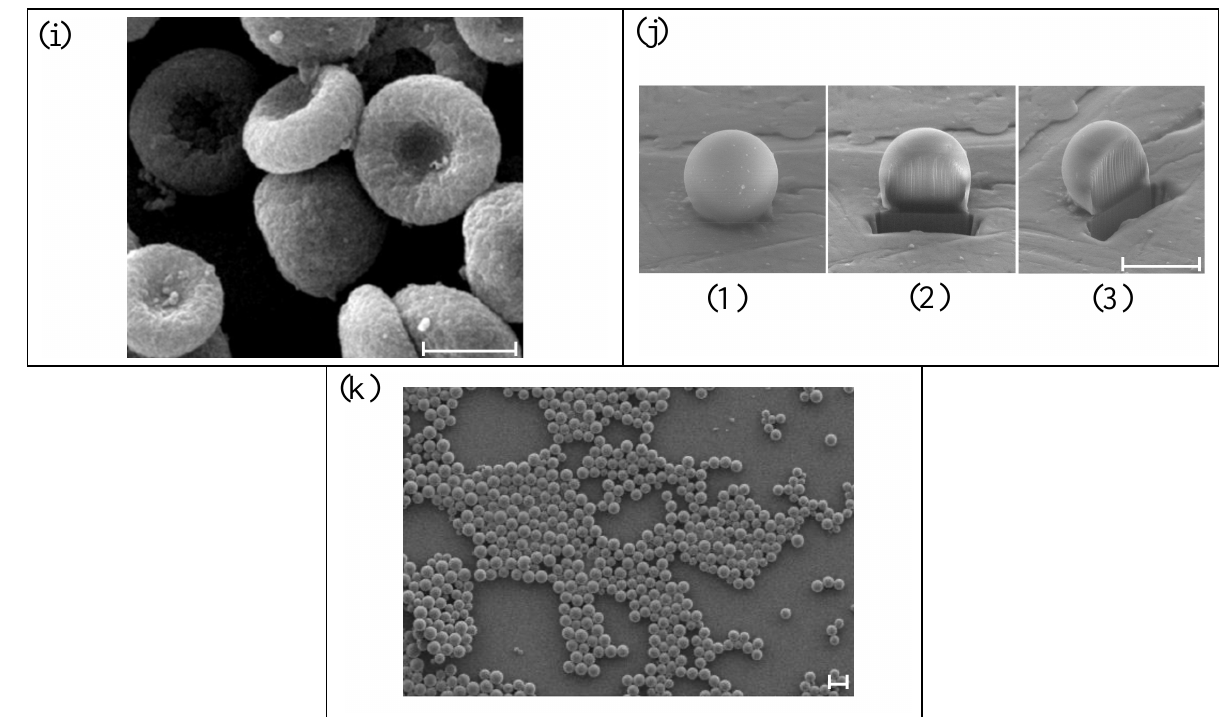
Figure 2. Images of microparticles (RBC templates) produced by using methods from Figure 1: ( a ) electrohydrodynamic jetting [34], ( b ) stop flow lithography (SFL) [35], ( c ) PRINT ® [37], ( d ) electrohydrodynamic (electrospraying) [39], ( e ) layer- by-Layer from solid template (LbL) [41], ( f ) LbL from porous template [42], ( g ) CAP ATRP [43], ( h ) liquid–liquid flow-focusing with a hypodermic needle [44], ( i ) electrospray with solvent diffusion [47], ( j ) two-syringe membrane emulsification [50], and ( k ) 512-channel geometric droplet-splitting microfluidic device combined with a post array part [51]. Scale bars are 5 µ m in ( a , d -(2), e , g , h ), 10 µ m in ( b , c , f , h , j , k ), and 50 µ m in ( d – 1 ). Numerals are used to explain, in the text, the information contained by each type of image. Reproduced from Refs. [34,35,37,39,41–44,47,48,50,51] with permission from National Academy of Sciences, Wiley Periodicals, Inc., WILEY-VCH Verlag GmbH & Co. KGaA, American Chemical Society, AIP Publishing, Elsevier Science INC, and